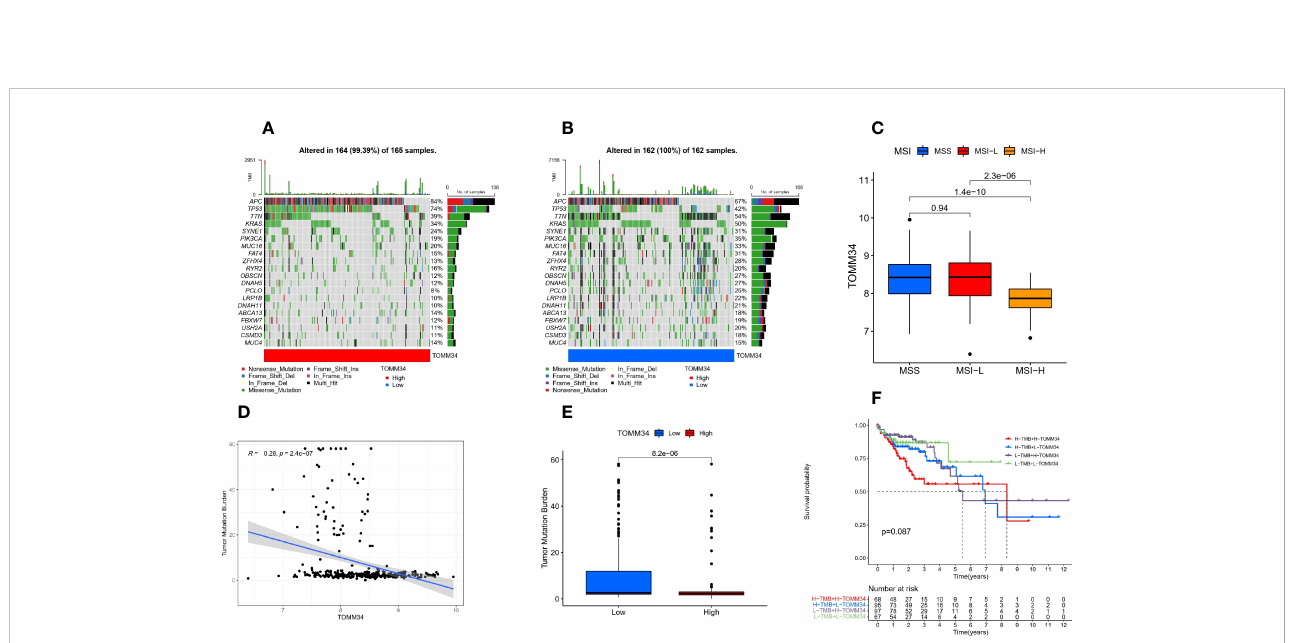
FIGURE 4 Somatic mutation analysis characteristics. (A) Distribution of the top 20 mutated genes in the high TOMM34 group. (B) Distribution of the top 20 mutated genes in the low TOMM34 group. (C) Correlation between TOMM34 and microsatellite instability (MSI), indicating that TOMM34 was negatively associated with high MSI. (D) Correlation between TOMM34 and tumor mutation burden (TMB), indicating that TOMM34 was negatively associated with TMB. (E) Boxplot showing the tumor mutation burden in the low and high TOMM34 groups. (F) Survival analysis of TOMM34 combined with tumor mutation burden, showing that patients with high TMB and high TOMM34 presented worse prognosis. MSI, microsatellite instability; MSS, microsatellite stability; MSI-L, low microsatellite instability; MSI-H. high microsatellite instability; H-TMB, high tumor mutation burden; L-TMB, low tumor mutation burden; H-TOMM34, high expression of TOMM34; L-TOMM34, low expression of